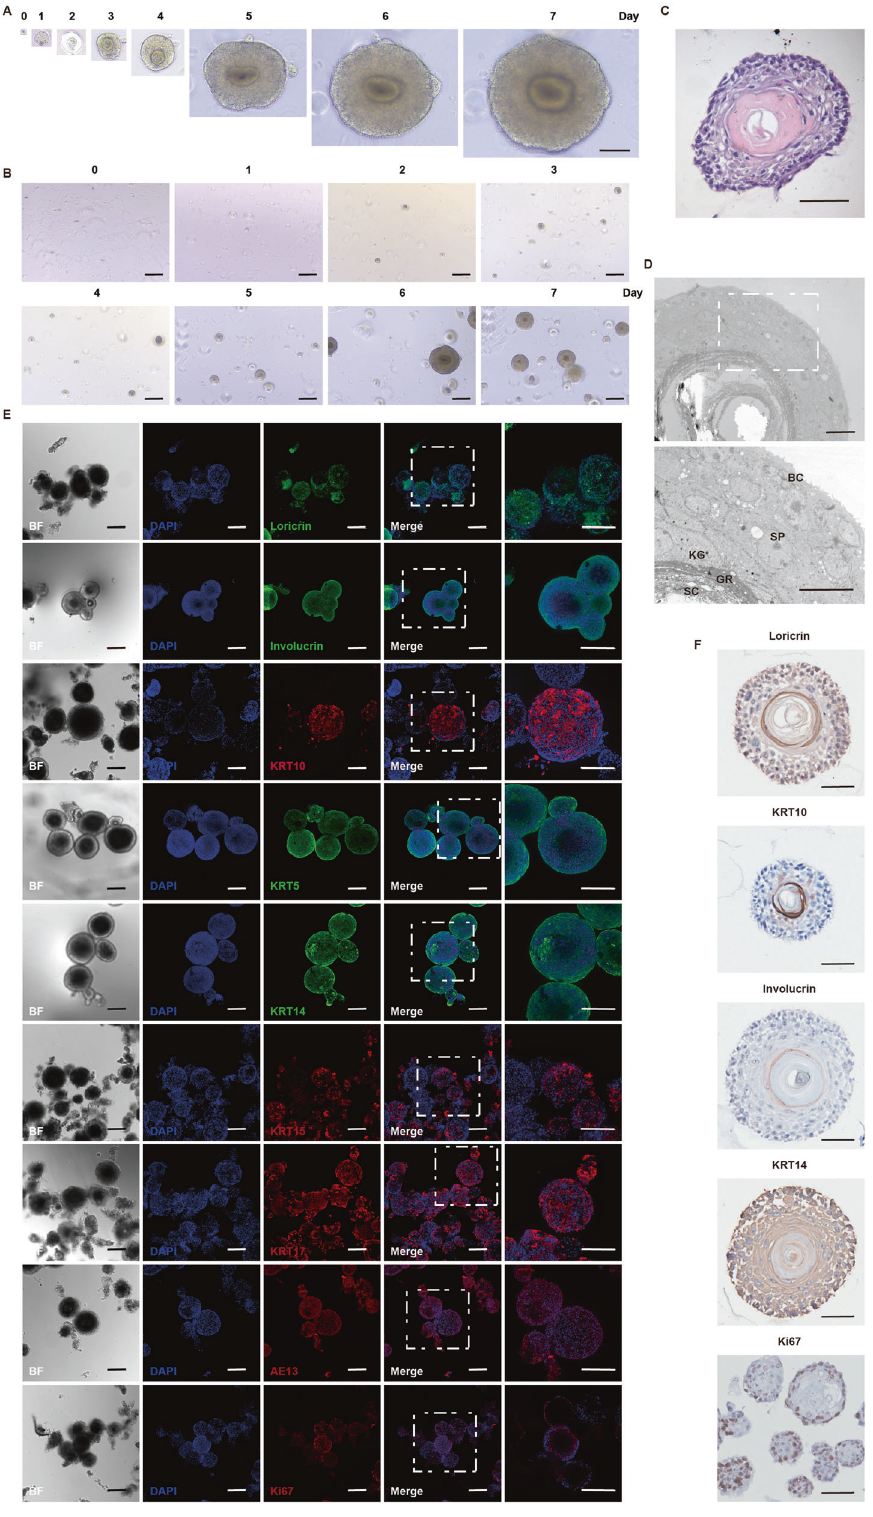
Fig. 1 Characterization of mouse primary epidermal organoids (mPEOs). A Overview of mPEOs formed from single cells within 7 d (scale bars, 100 μ m). B Increased number of mPEOs observed within 7 d in bright fi eld (scale bars, 100 μ m). C H&E staining of mPEOs cultured for 7 d (scale bars, 50 μ m). D Ultrathin sections in TEM images of mPEOs (scale bars, 20 μ m), SB stratum basale, SP stratum spinosum, GR stratum granulosum, KG keratohyalin granules, SC stratum corneum. E Immuno fl uorescence staining analysis of various skin-associated speci fi c biomarkers in mPEOs (scale bars, 200 μ m). F Immunohistochemical staining of paraf fi n-embedded mPEOs. Representative images of Loricrin, KRT10, Involucrin, KRT14 and Ki67 immunoreactivity in organoids (scale bars, 50 μ m).